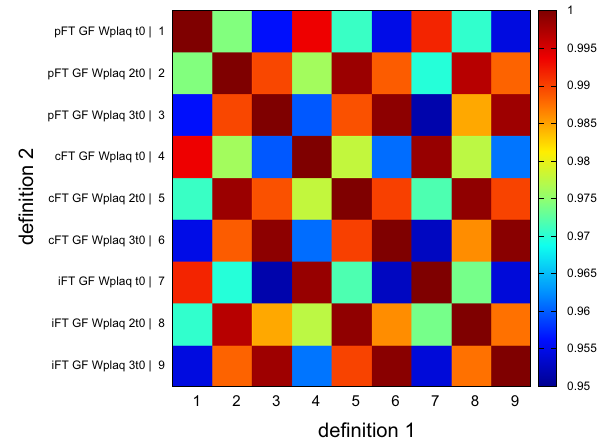
Fig. 16 Comparison of field theoretic definitions with GF smoothing and different discretizations of the topological charge operator. The correlation between different definitions is colour-coded (note the scale is different than in Figs. 9, 10, 15, 14)